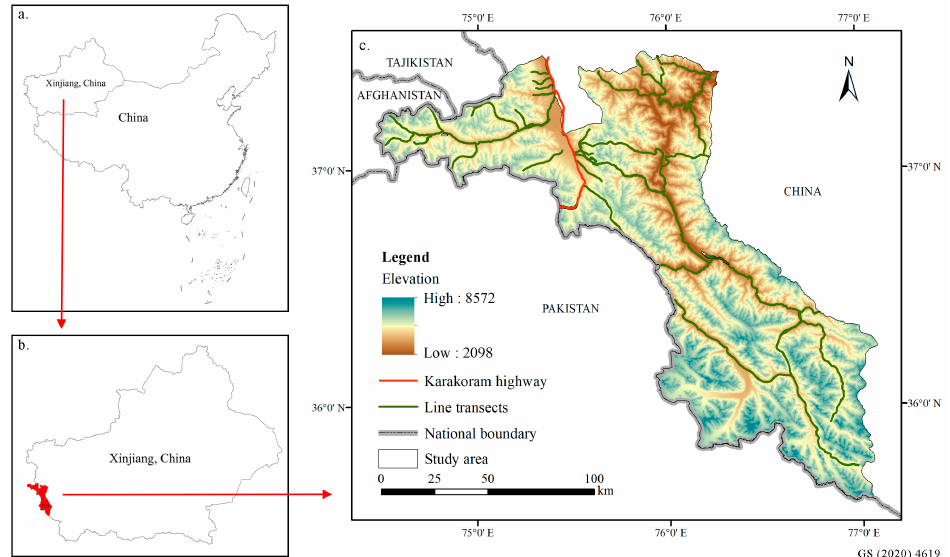
Figure 1. The study area is located in the west of China, which borders Tajikistan, Afghanistan, and Pakistan. ( a ) A map of China. It reflects the location of Xinjiang, a province in China. ( b ) Taxkorgan Nature Reserve (TNR) is located in the southwest of Xinjiang, China. ( c ) The map shows the borders of the Taxkorgan Nature Reserve, with elevation indicated on a green to orange scale. The Karakoram highway is indicated as a red line transect.